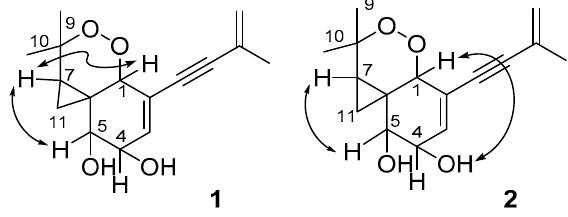
Figure 7. Key NOESY correlations of compounds 1 – 2.